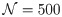
Colonies with mixtures of of cells sensitive to different wavelengths.Colonies are assumed to consist of two types of cells, each of which senses only one of the light sources. The cell types are indicated by green and red colors, corresponding to the wavelength of light they are sensitive to. The two different light sources, of the same intensity (and hence same pphoto), are placed at angles 30° (a, d, g), 60° (b, e, h) and 90° (c, f, i) North/South of East as shown in the respective figures. We consider the following proportions of cells that sense only red to those that sense only green: (a-c) 50:50 (d-f) 75:25 (g-i) 90:10. Each colony contains N=500 cells, and the model was simulated for 4 × 104 time steps for the case where pphoto = 0.05 for both the red and green sensitive cells.